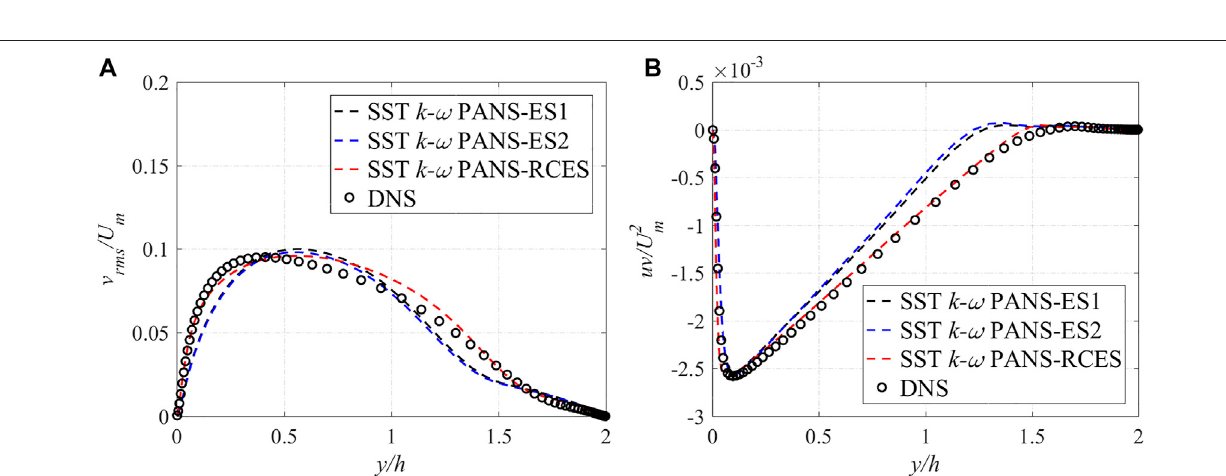
Frontiers in Energy Research |